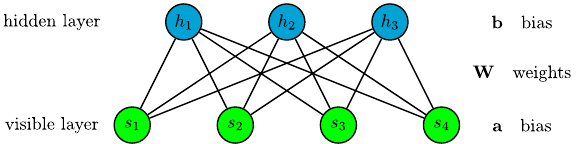
Figure 1. Network diagram of the restricted Boltzmann